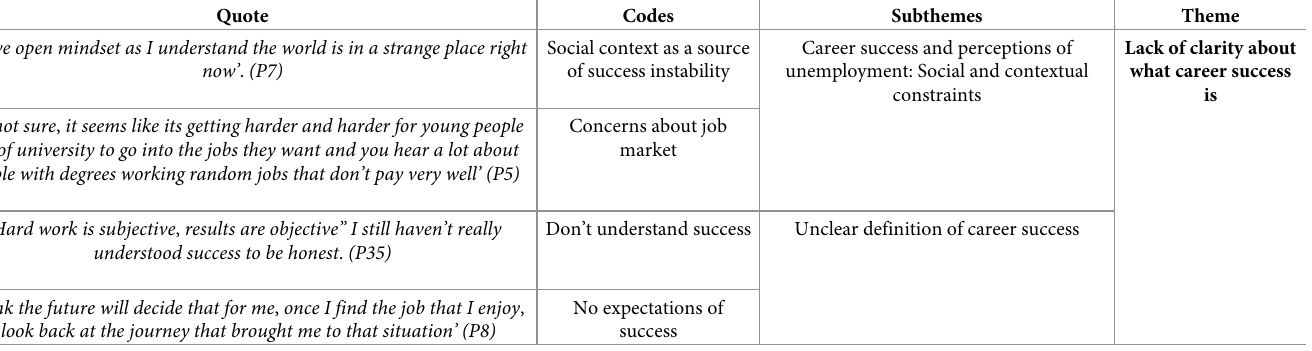
Table 4. “Lack of clarity about what career success is”: Subthemes, codes and